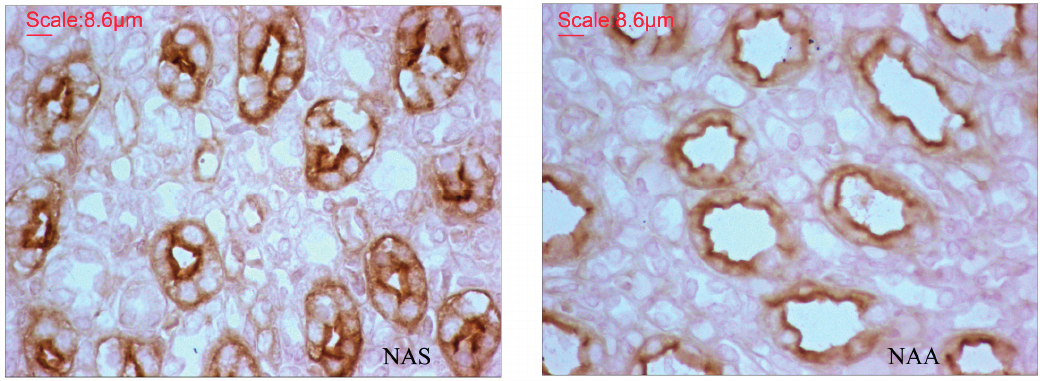
Figure 4. Distributions of AQP2 protein in the medulla of the renicule in NAS and NAA. The dark yellow color shows that AQP2 protein localized to the collecting